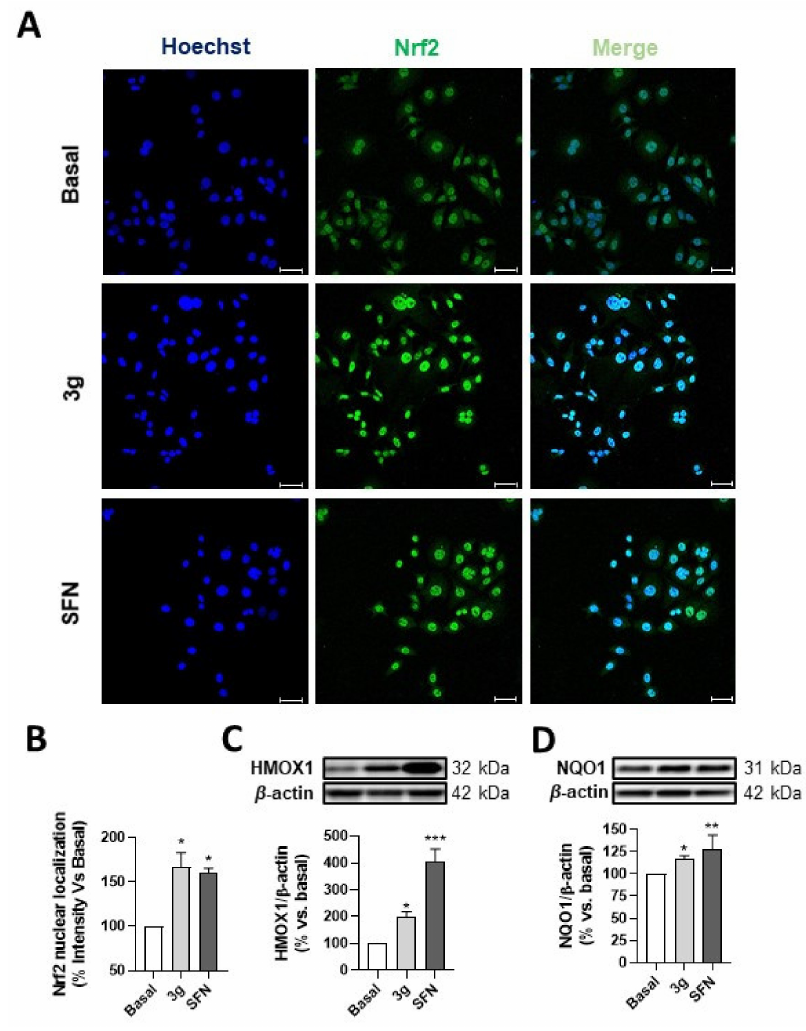
Figure 4. Compound 3g effectively induces Nrf2 translocation and overexpression of Nrf2-ARE dependent genes in AREc32 cells. ( A ) AREc32 cells were treated with compound 3g (30 µ M), sulforaphane (10 µ M), or culture medium (Basal) for 1 h; the cells were next processed for immuno- cytochemistry and stained with anti-Nrf2 (green) and Hoechst (blue). ( B ) Nrf2 nuclear localization analysis, measured as integrated intensity localized at the nucleus. HMOX1 ( C ) and NQO1 ( D ) expression in AREc32, measured by Western blot analysis. Cells were treated with compound 3g (30 µ M), sulforaphane (10 µ M), or culture medium (basal) for 24 h and protein expression was then assessed. Graphs are expressed as densitometric quantification using β -actin for normalization (bottom). Scale bar: 25 µ M. Data are expressed as mean ± S.E.M. of six independent experiments. Sta- tistical analysis was performed using one-way ANOVA: ( p < 0.05); * p < 0.05; ** p < 0.01; *** p < 0.001 vs. basal